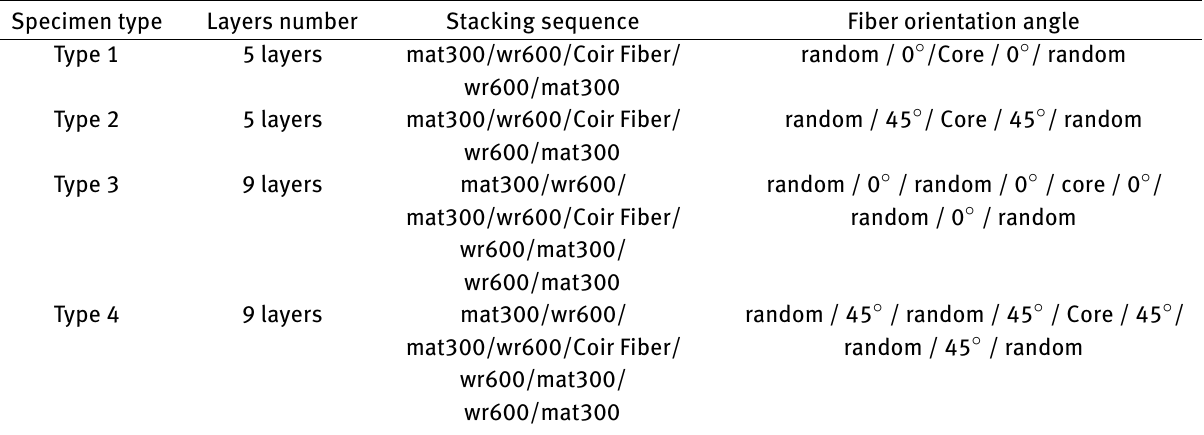
Table 1: Laminate type configurations in layers number, stacking sequence, and fiber orientation angle Specimen